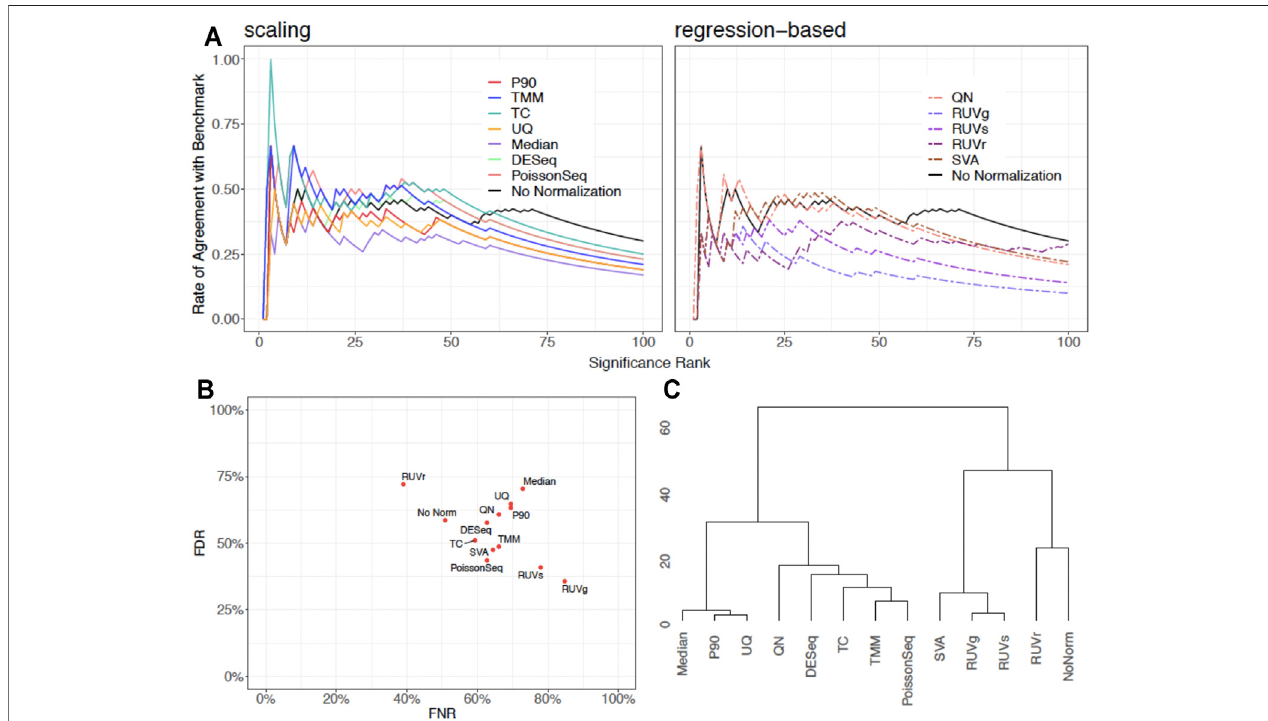
FIGURE 1 | Graphical display of empirical assessment results for P90 normalization in comparison with no normalization and nine normalization methods using PRECISION.seq . (A) CATplot of p -value ranking determined in the test data that undergoes scaling normalization (left panel) or regression-based normalization (right panel), in comparison with no normalization. (B) Scatterplot of False Negative Rate and False Discovery Rate among the normalization methods. (C) Dendrogram for clustering the p -values in the test data before and after normalization.